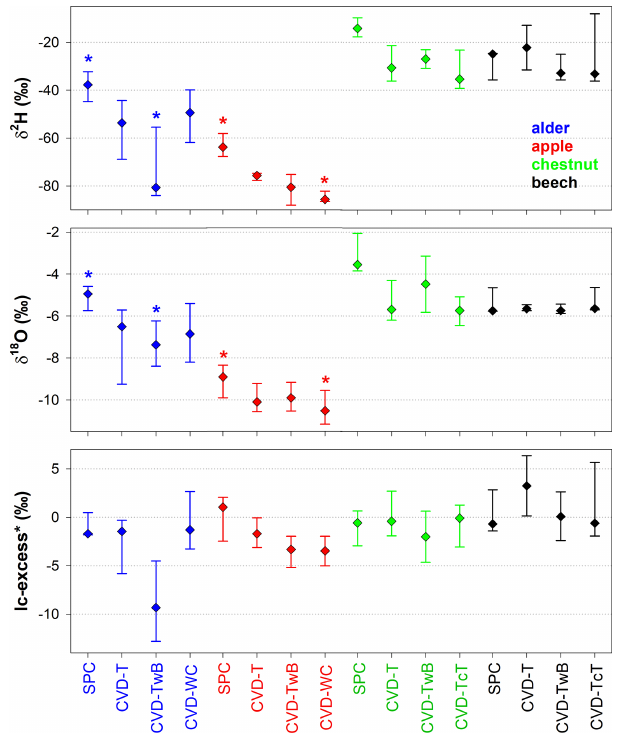
Figure 7. Median isotopic composition and lc-excess ∗ of plant wa- ter extracted by SPC (i.e., Scholander-type pressure chamber) and CVD (i.e., cryogenic vacuum distillation), grouped by plant tis- sue and species. Error bars represent the minimum and the maxi- mum values. Asterisks above the dots indicate significantly different groups ( p < 0 . 05, multiple comparison test based on Tukey method run after the Friedman repeated measures analysis of variance on